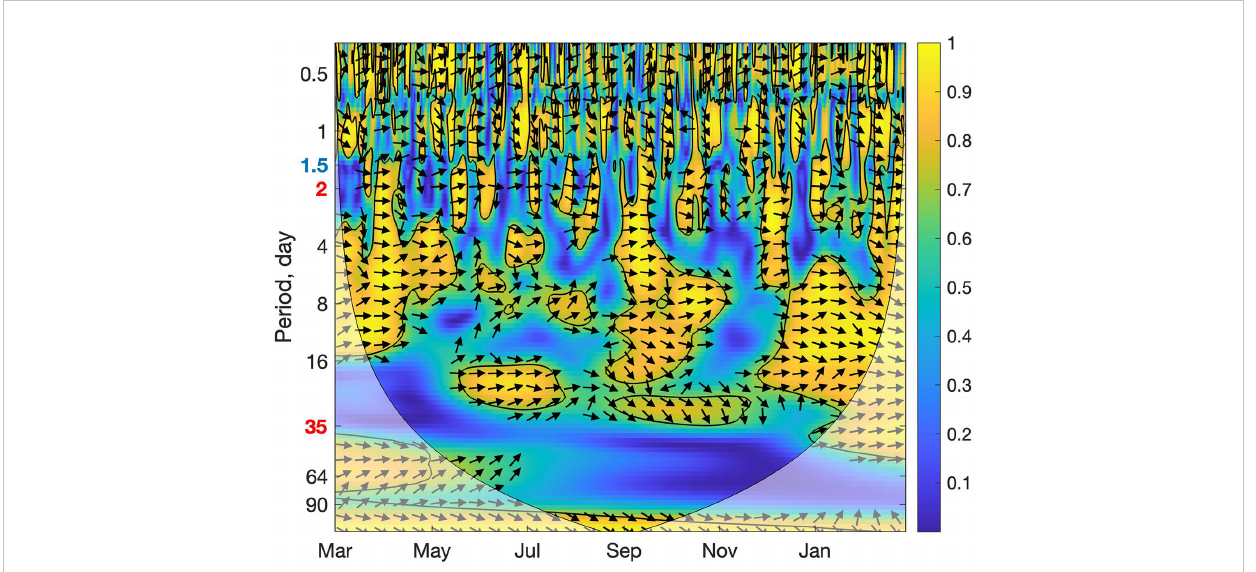
FIGURE 3 The squared wavelet coherence R 2 n (s) between the area-averaged melt rate time series of MUIS (brown line in Figure 2) and TIS (blue line in Figure 2) in the 2014 simulation year. The low frequency cutoff for tidal periods (1.5 days) is labelled in blue and the lower (35 days) and upper (2 days) frequency cutoffs for the eddy period are labelled in red on the period axis. The color bar indicates a measure of coherence (Eqn. 2). The 95% signi fi cance level against a randomized Fourier noise background (see text) is shown as thick contours and the arrows show the relative phase relationship, which is in-phase pointing right, anti-phase pointing left, an arrow pointing straight up means that the TIS leads MUIS melt by 90° at that period, and an arrow pointing down means that TIS lags MUIS by 90°. Moreover, ↗ indicates basal melting of TIS is leading basal melting of MUIS by 45°, and ↘ indicates basal melting of MUIS is leading basal melting of TIS by 45°. The transparent white regions along the edges of the plot represent regions where data boundaries affect the WTC operation, and so represent places where con fi dence in signi fi cance is reduced (Grinsted et al.,